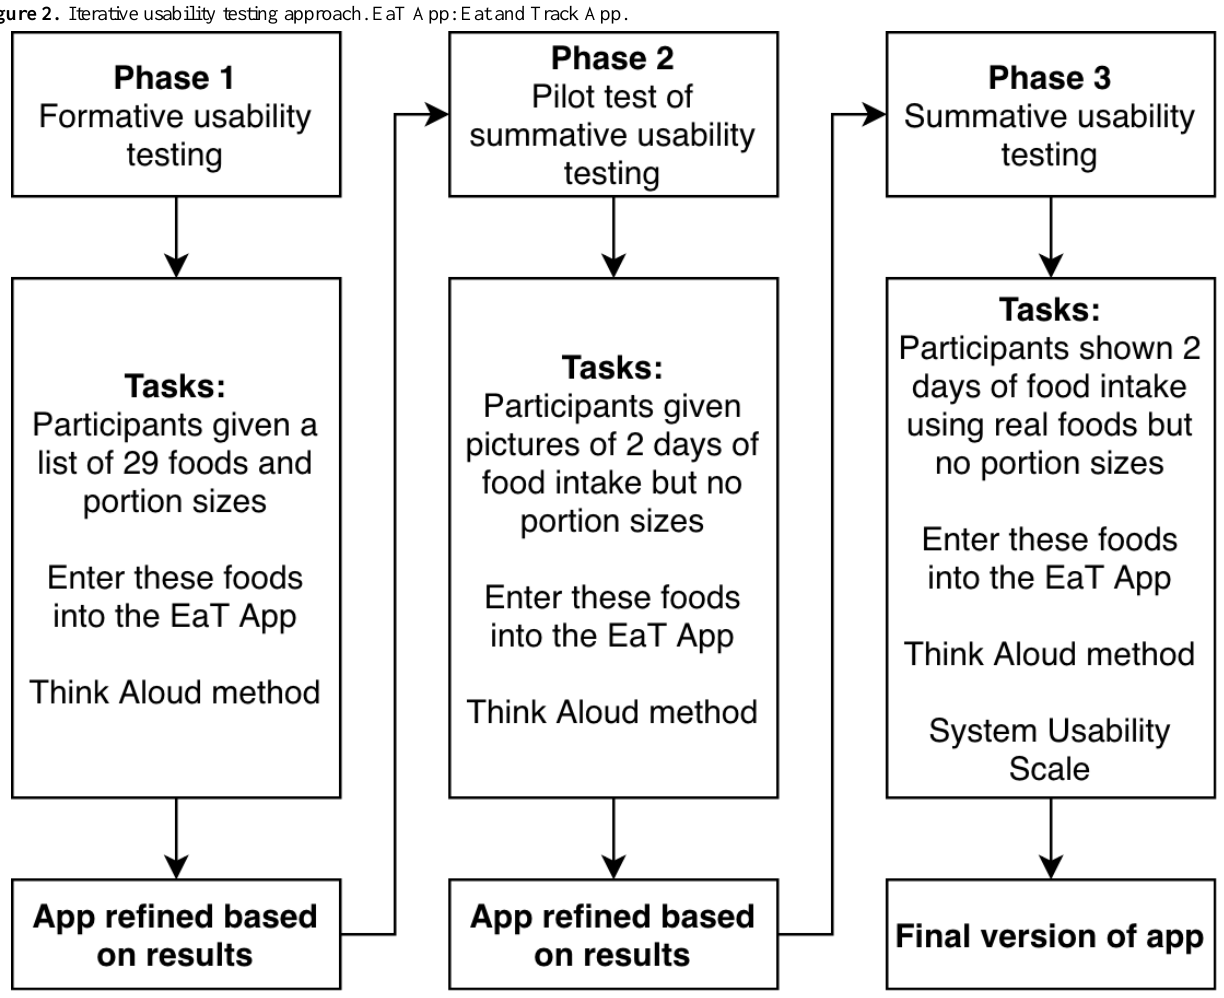
Figure 2. Iterative usability testing approach. EaT App: Eat and Track